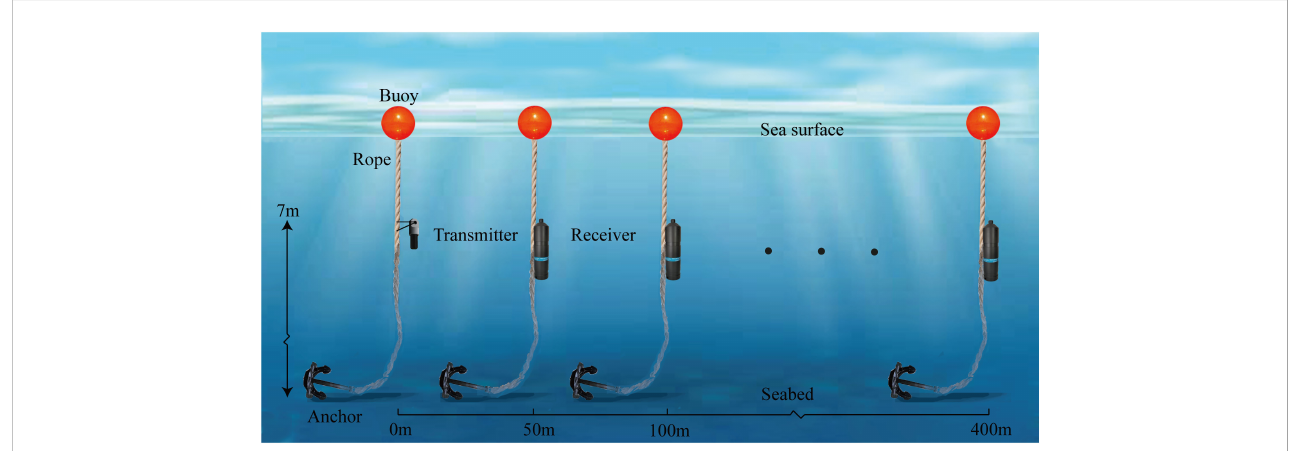
FIGURE 1 Schematic of range test experiment showing the deployment of the moored transmitter and receiver. The range test transmitter (not attached directly to the rope) was moored in the front (0 m), and eight receivers were moored at fi xed distances from the transmitter (50, 100, 150, 200, 250, 300, 350, and 400